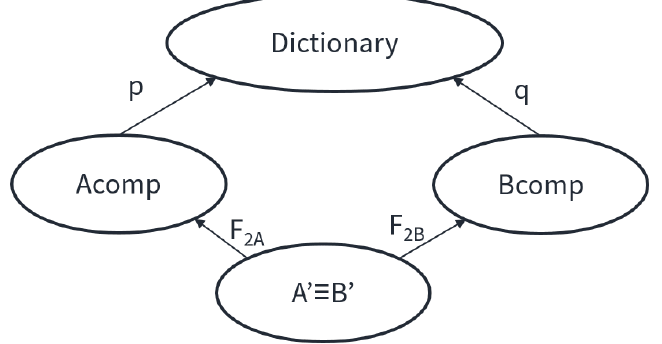
Figure 18. The pullback of A comp and B comp with regards to the